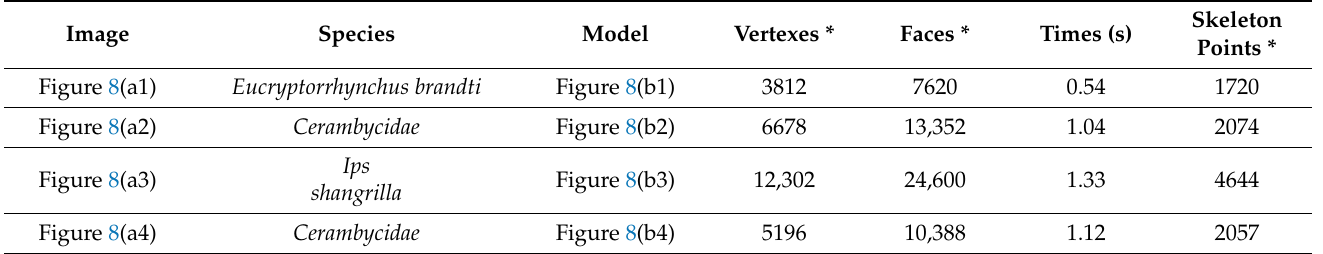
Figure 8. Three-dimensional reconstruction and skeleton extraction: row ( a ) represents the input image; row ( b ) represents the 3D model generated from the 2D contour of the image in row ( a ); row ( c ) represents the 3D skeleton extracted from the 3D model in row ( b ). Table 2. Reconstruction of 3D model and 3D skeleton specific data.